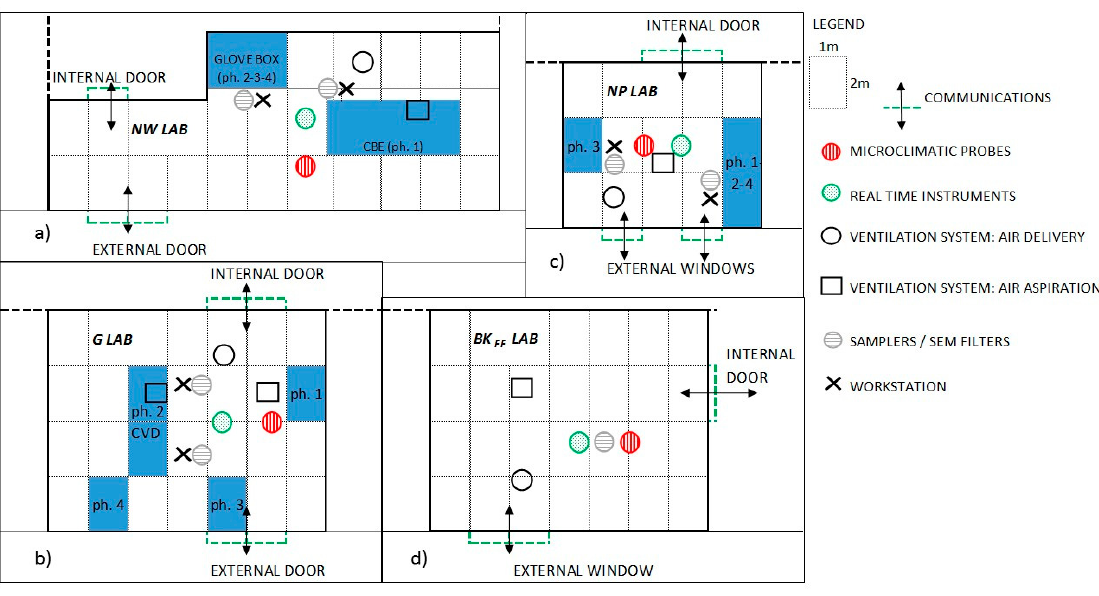
Figure 7. Schematic maps of the NW lab ( a ), G lab ( b ), NP lab ( c ) and Bkg FF lab ( d ), including the places where each phase (ph.) of the three processes was done and the location of the FF background